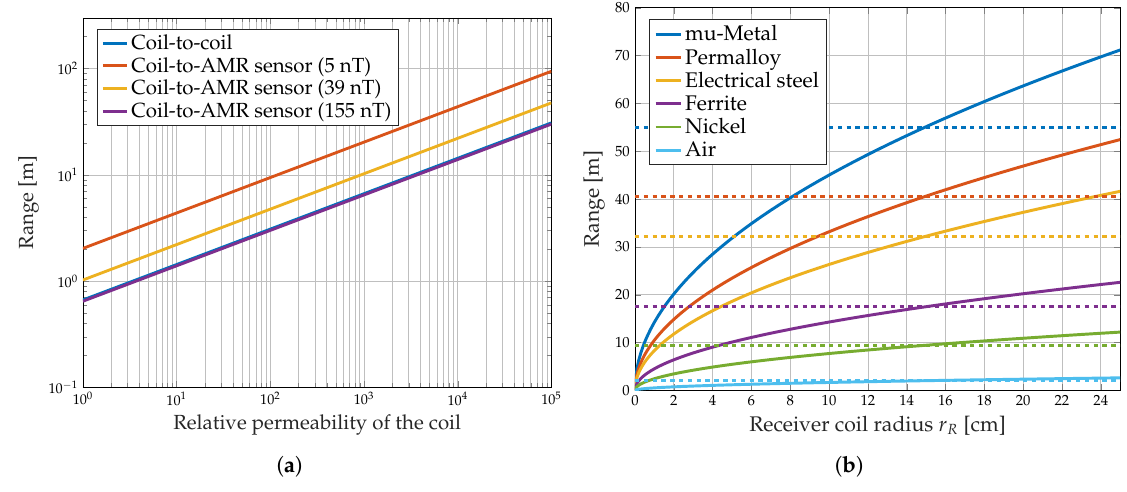
Figure 6. Transmission range for coil-to-coil and coil-to-AMR communication depending on the permeability ( a ) and the receiver coil radius for different core materials ( b ). Parameters are taken from Tables 2 and 3. The dashed lines are for coil-to-AMR